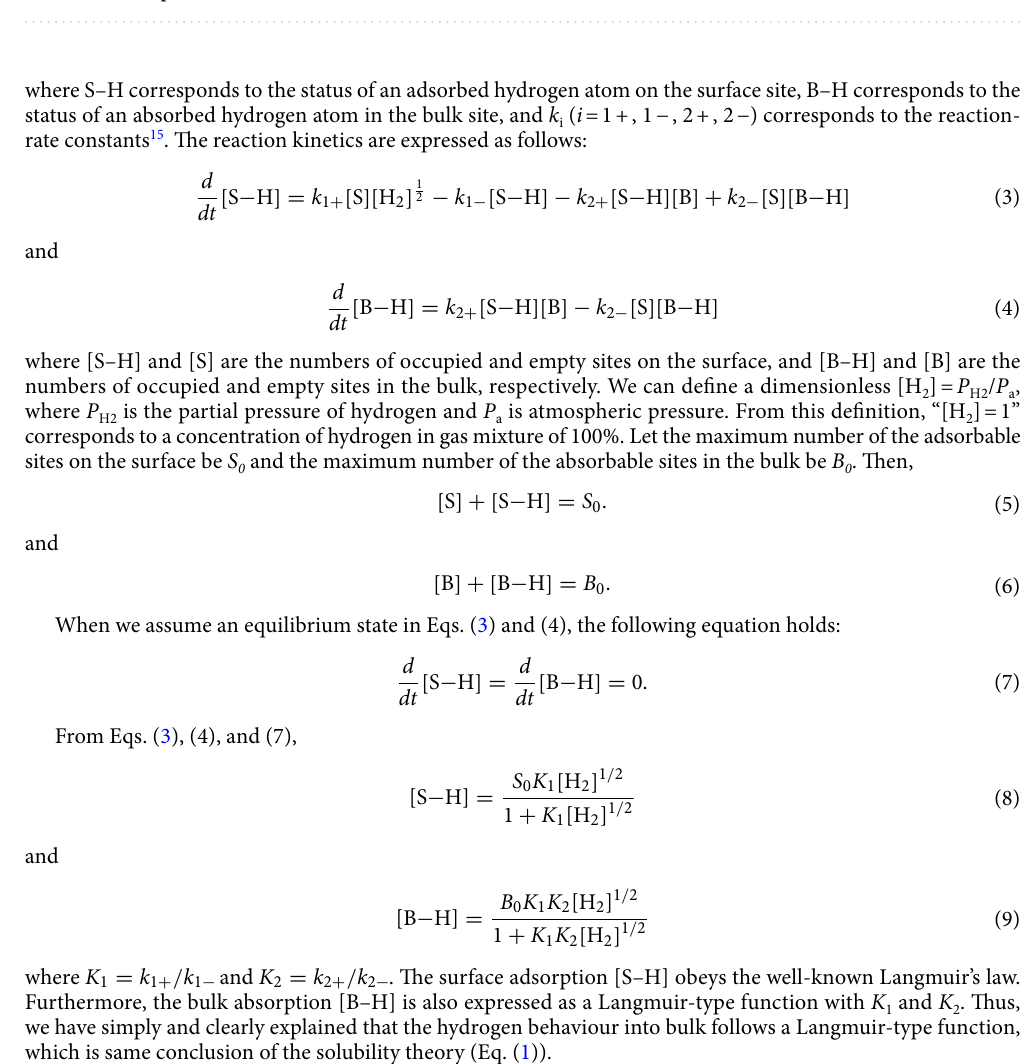
Figure 4. Peak jump heights of MSS output voltage (ΔV) plotted against square root of hydrogen concentration (C 1/2 ). Inset: Expansion at low